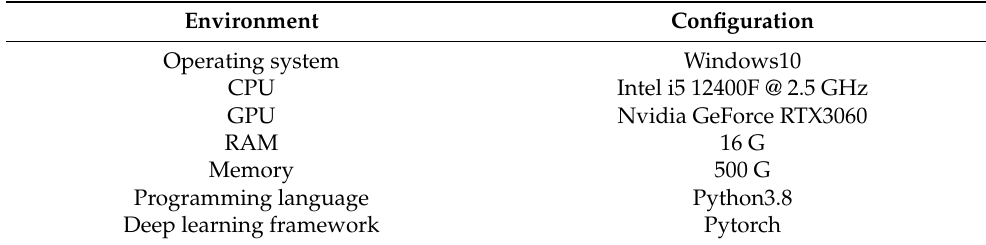
Table 1. Experimental environment and configuration.